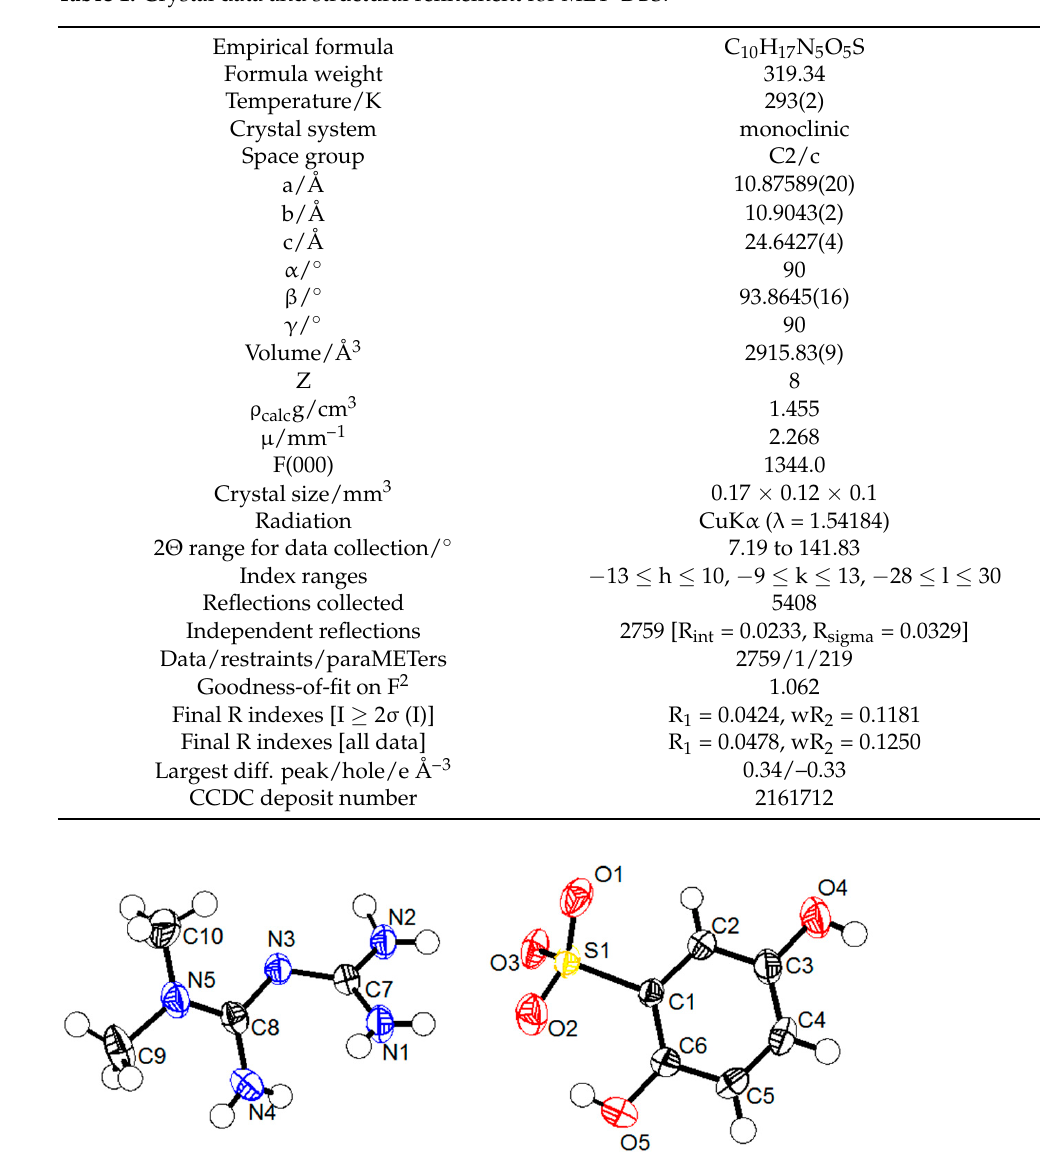
Table 1. Crystal data and structural refinement for MET–DBS.